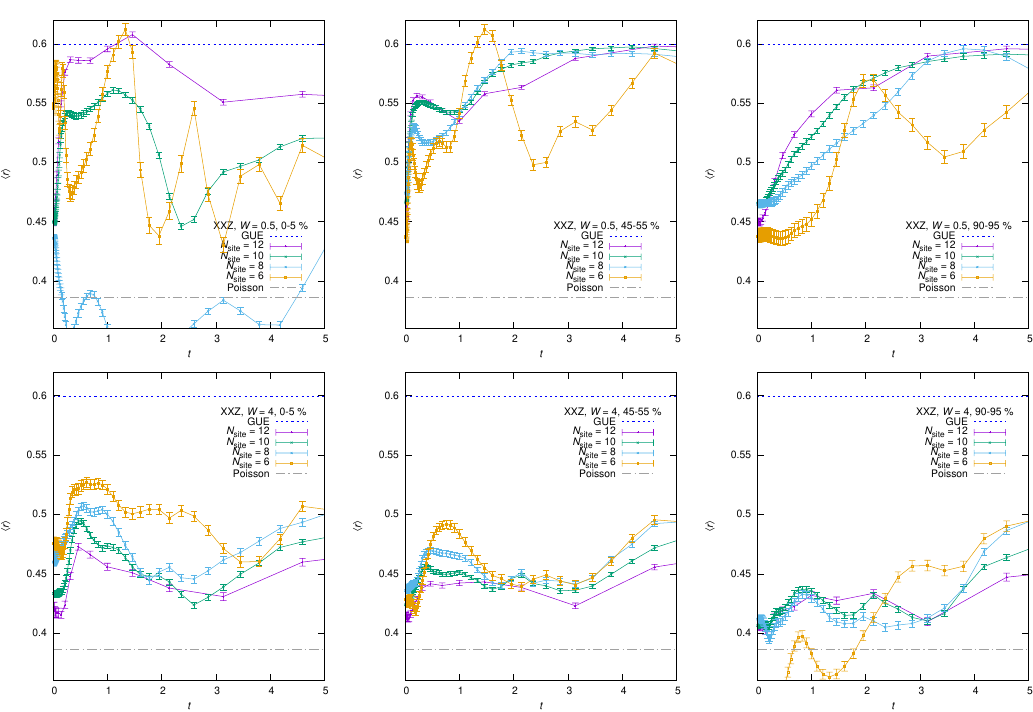
Figure 22 . XXZ model, plot of averaged nearest gap ratio h r i , obtained using individual gap unfolding for the two gaps between the three largest exponents for N site = 12 ; 10 ; 8 ; 6. Top: W = 0 : 5. Bottom: W = 4. Both in upper and lower rows, the plots are obtained using the eigenstates in between [left] 0% and 5%, [middle] 45% and 55%, and [right] 90% and 95% of the energy spectrum for each